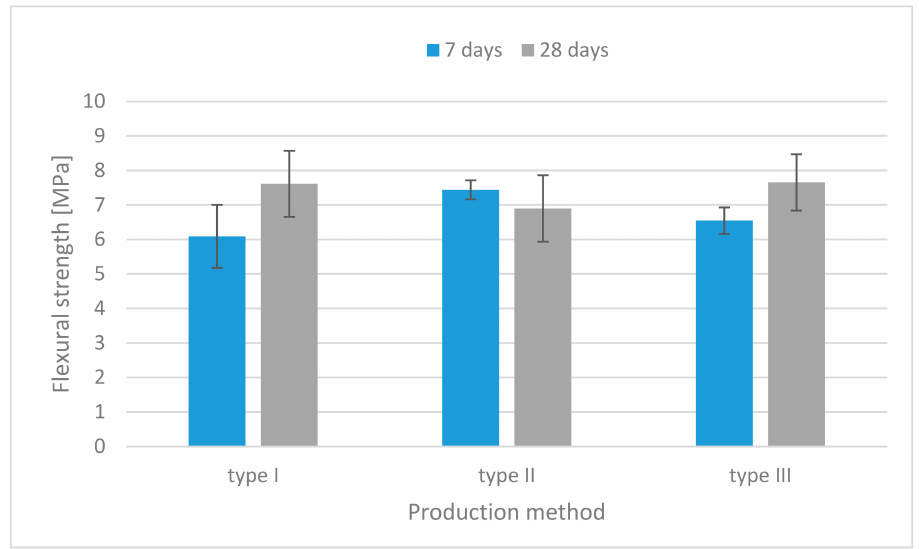
Figure 6. Flexural strength histograms (specimens without fibers).